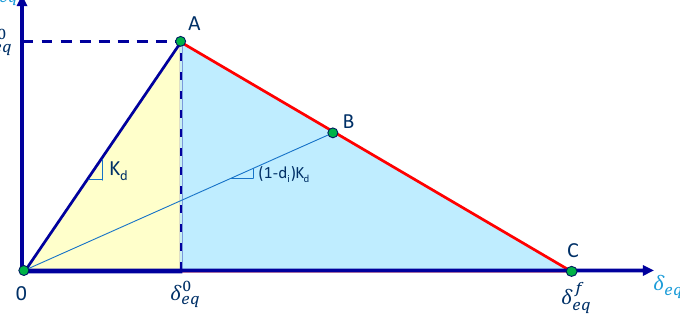
Figure 1. Constitutive relation (damage onset and evolution).